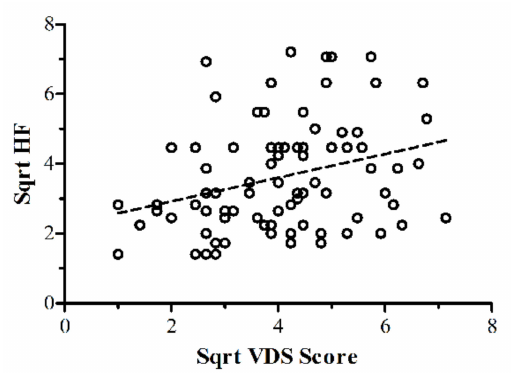
Figure 4. Scatterplot of yearly SqrtHeadache Frequency correlated with SqrtVDS for the migraine headache group showing a correlation of moderate size